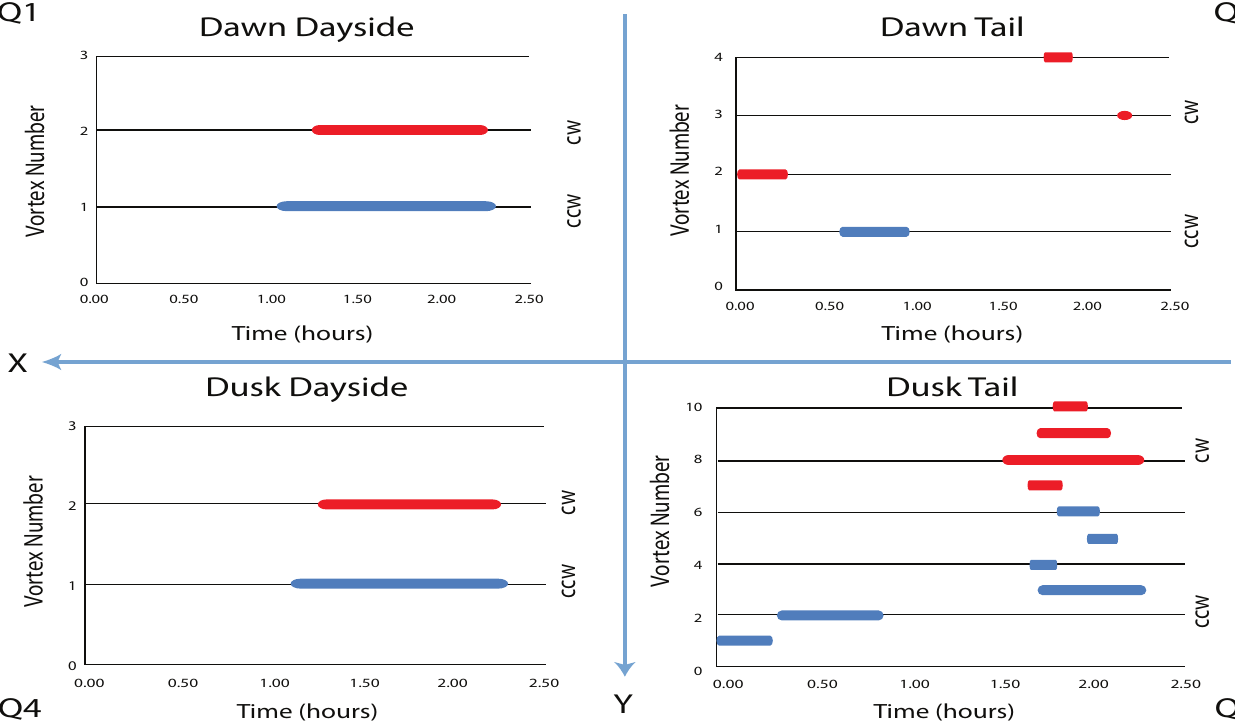
Fig. 2. Time duration of vortices for case 1. The x axis represents the number of vortices and the y axis represents the time in hours for each of the 4 quadrants. The blue X and Y arrows are just to show the separation in each of the four quadrants, X positive being in the sunward direction and Y positive in the duskward direction. The vortices rotating in the clockwise direction are represented in red color, and the ones rotating counterclockwise are represented in